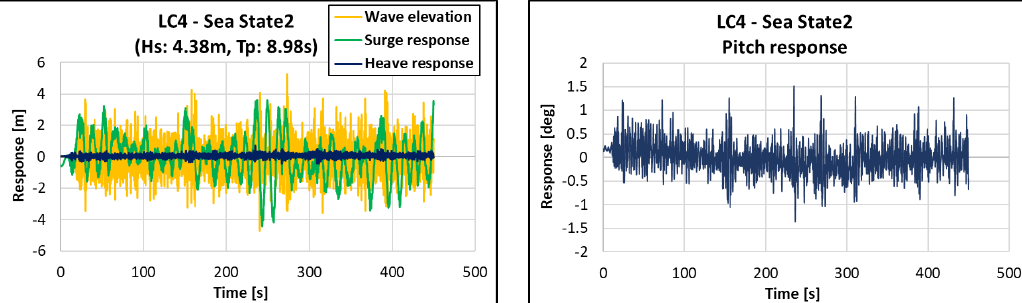
Figure 12. LC4 Sea state2 Time-series response.